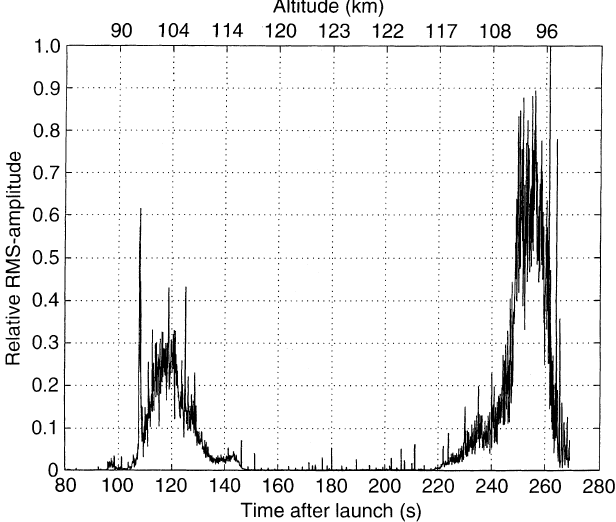
Fig. 4. Root-mean-square power of the fluctuations in potential U 5 in arbitrary units as a function of time after launch. In the top of the figure the corresponding altitudes